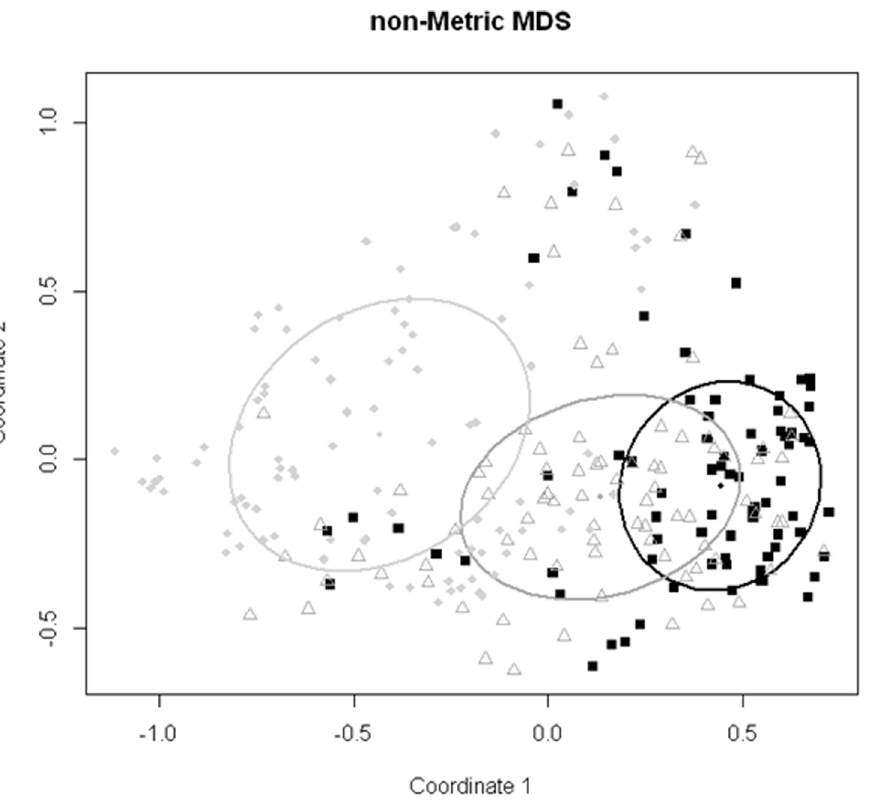
Figure 4. Non-metric multi-dimensional scaling ordination plot of the distance between bacterial communities based on the Bray- Curtis distance. The ellipses represent the samples which were within 75% confidence limit of the centroids and included the wet bank (circles), dry bank (triangles) and the terrestrial samples (squares) (Stress=0.12).